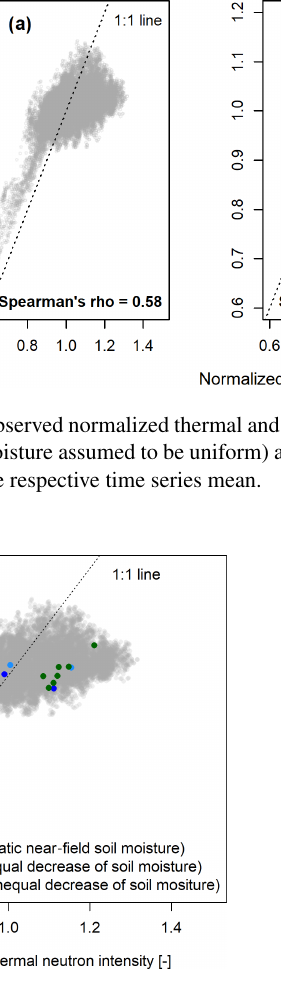
Figure 9. The relationship between normalized thermal and epither- mal neutron intensities for in situ observations, and the relationship between the normalized detected epithermal and thermal neutrons for simulated data. The simulated values refer to the simulation set and scenarios summarized in Table 1. Simulated neutrons are nor- malized by the average number of detected neutrons of all simula- tions in the respective energy